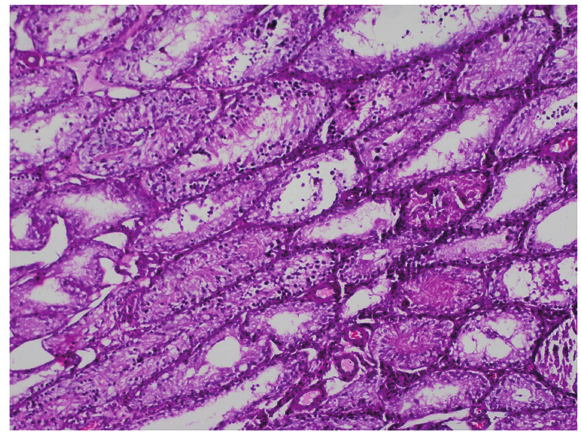
figure 1 - Histopathology image of the testis parenchyma obtained from the papaverine group (Group 3) (cosentino Grade 2).